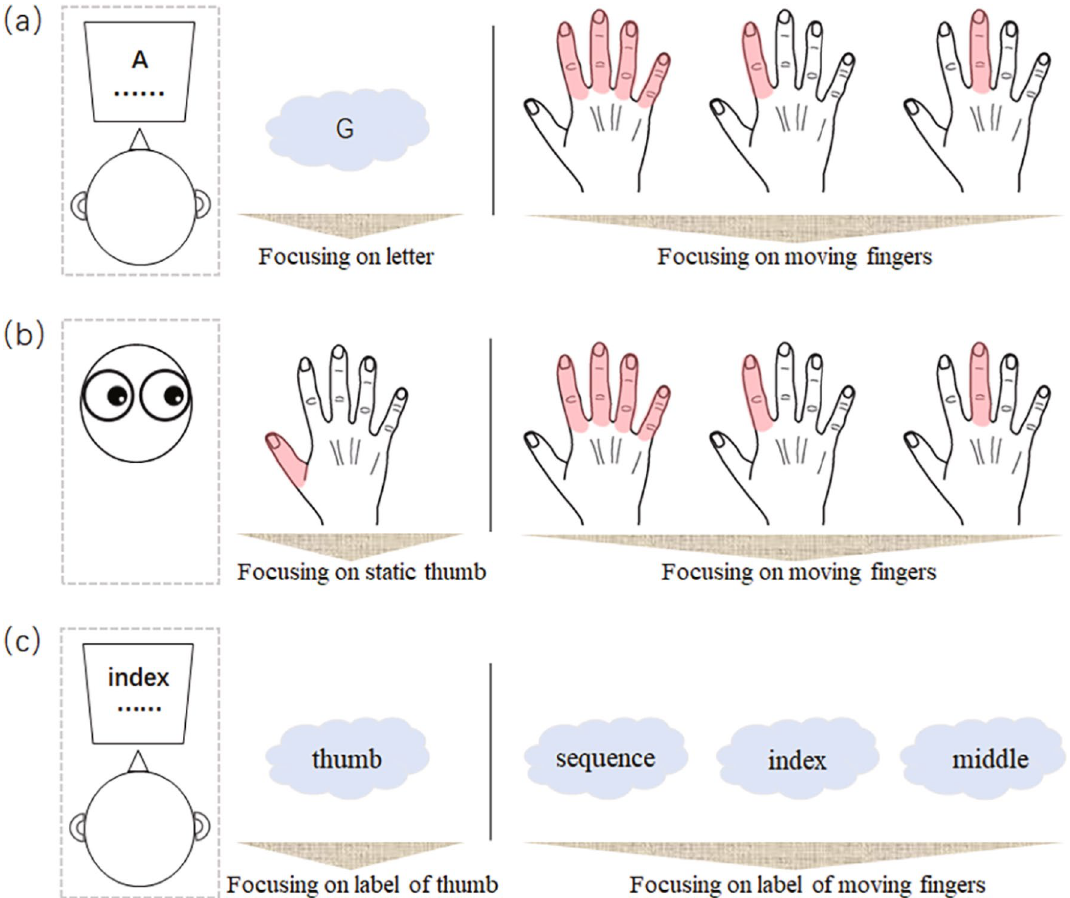
Figure 1. Schematic illustration of the experimental paradigm of ( a ) experiment 1, ( b ) experiment 2, and ( c ) experiment 3 . In experiments ( a ) 1 and ( c ) 3, a secondary letter-counting or label-counting task was performed simultaneously with the finger-tapping task. The focus of attention was manipulated in each experiment so that either different tapping fingers (indicated by the pink shade on hand) were attended [experiments ( a ) 1 and ( b ) 2], or different labels of particular fingers were attended [experiment ( c )